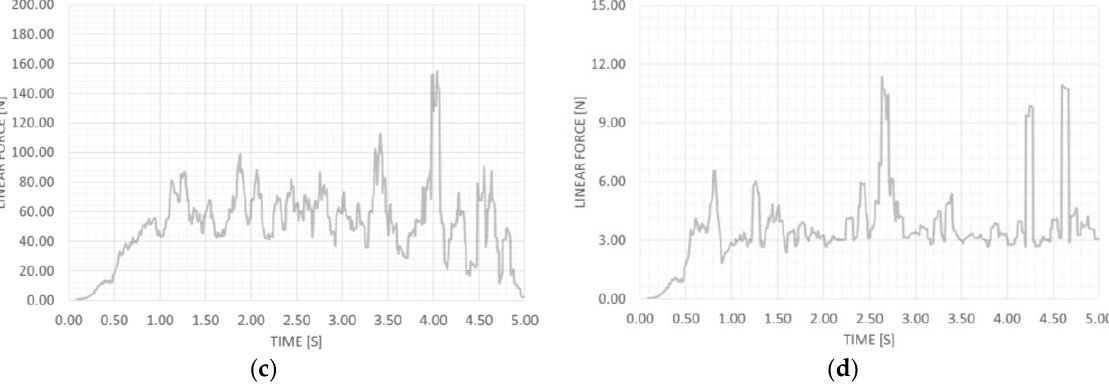
Figure 12. Simulation results for the limb simulation: ( a ) Linear displacement input, ( b ) Computed Forearm COM X displacement, ( c ) Computed torque for arm motion, ( d ) Computed torque for forearm motion.